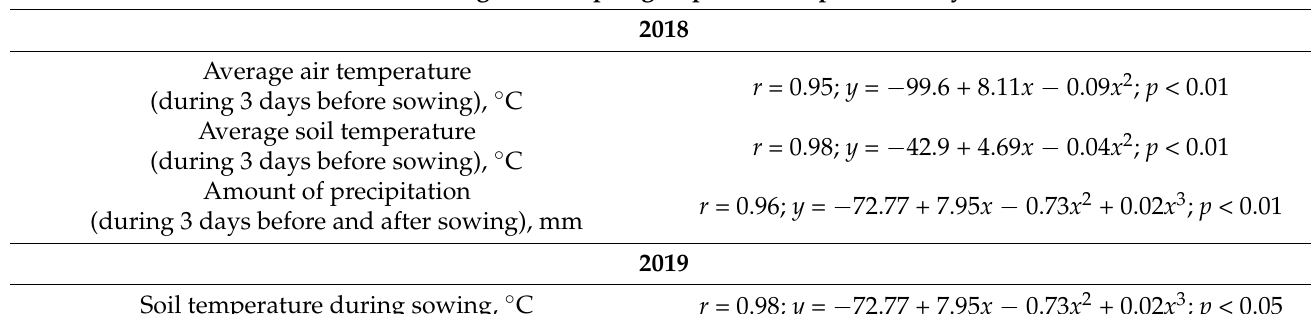
Table 3. Correlation between the field emergence of spring rapeseed crop 3 days after the emergence of the first seedling (y) with meteorological conditions (x),